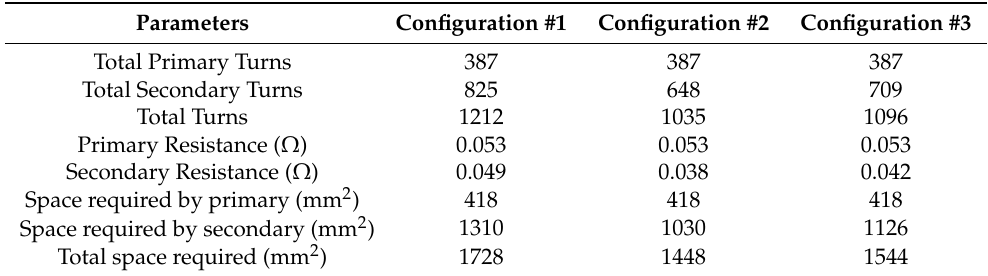
Table 2. Comparative analysis of different configurations for the application of three-phase to five-phase transformation.